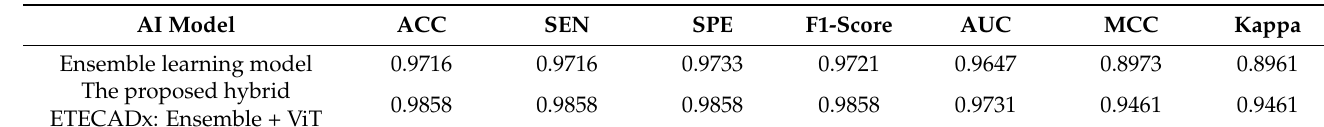
Table 5. Binary approach classification evaluation performance of the proposed ETECADx framework against the ensemble learning model using the testing set of INbreast dataset.